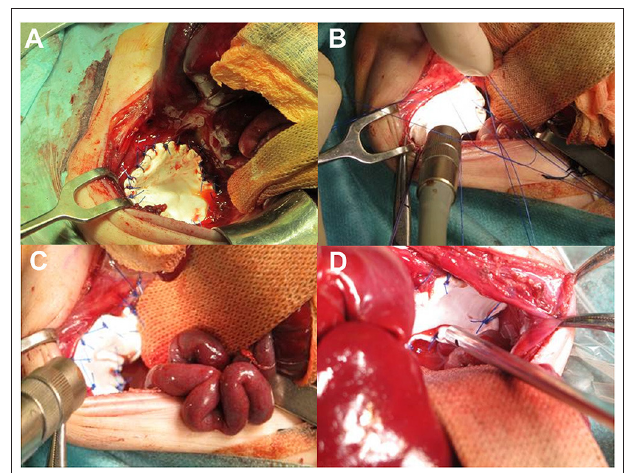
FIGURE 1 | Intraoperative imaging of patch repair. (A,B) Dome-shape patch repair. (C,D) Cone-shape patch repair.